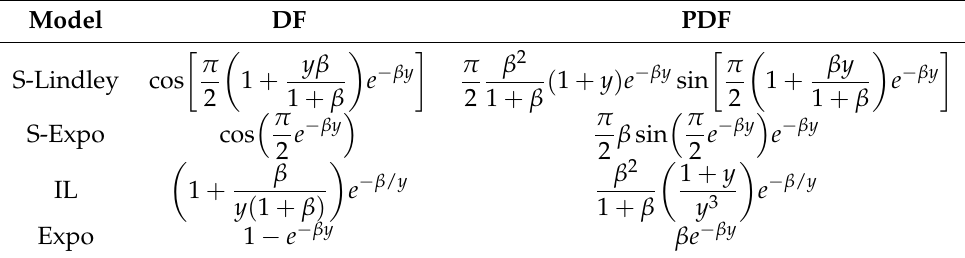
Table 1. DF and PDF of the competitive models used against the S-ML